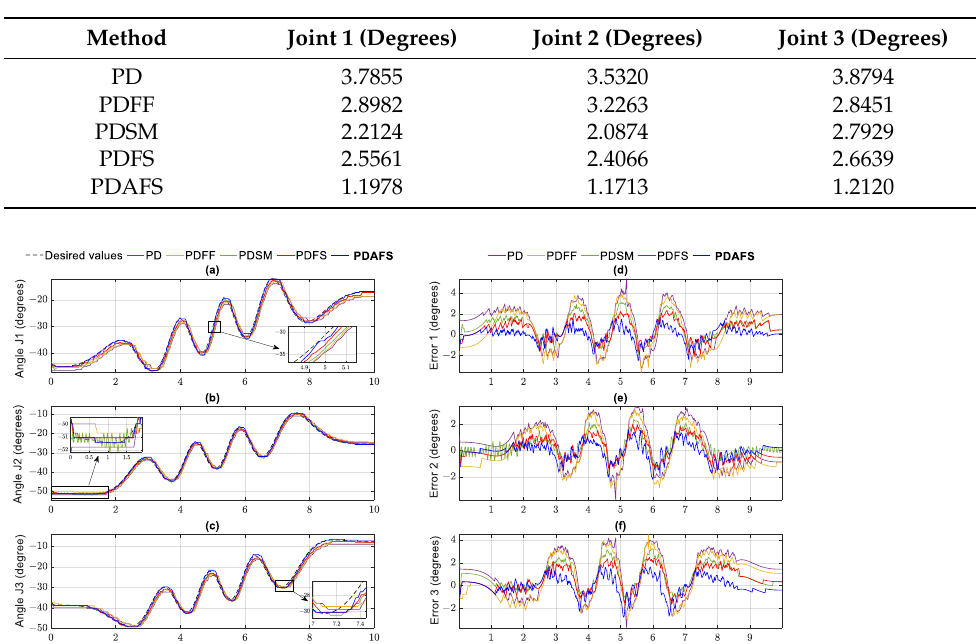
Table 10. RMSE Comparison among the controllers and PDAFS in Parabolic Case 1.